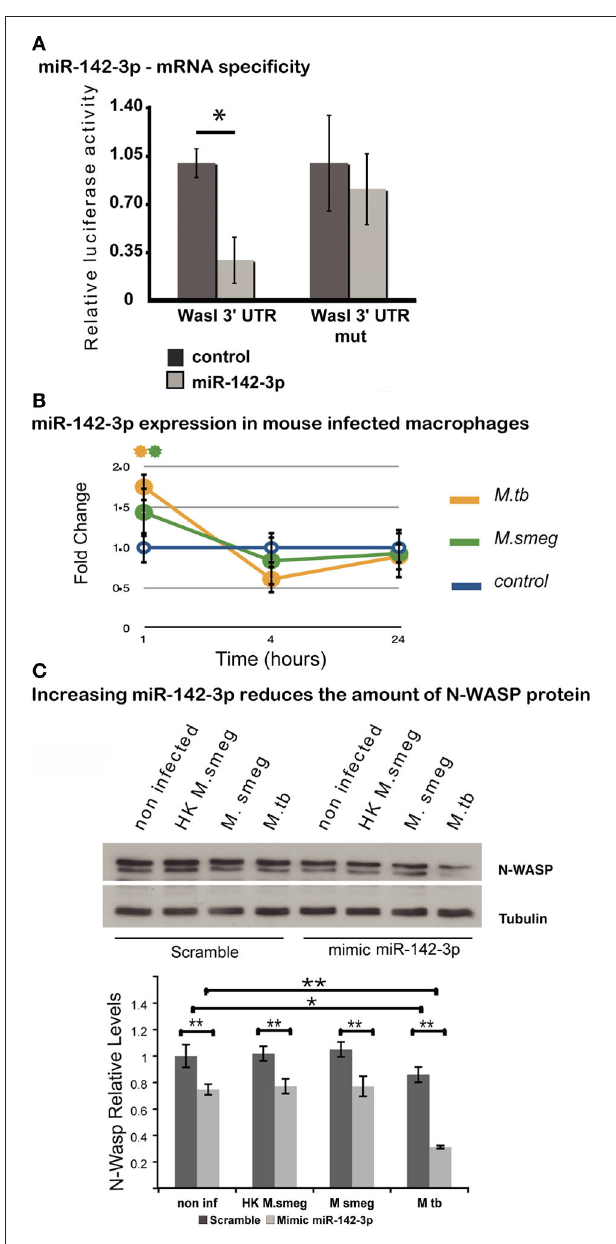
FIGURE 2 | N-Wasp is a target of miR-142-3p. (A) Luciferase assay showing the specific targeting of the 3 (cid:2) UTR of the mRNA of Wasl by the miR-142-3p. Data are represented as the mean fold change per sample ± SD ( ∗ P ≤ 0 . 01). (B) Relative expression of miR-142-3p in J774A.1 macrophages infected with M. smegmatis or M. tuberculosis (MOI 10), as measured by the EXIQON (DK) microRNA qPCR services. Data is represented as the mean fold change per sample ± SD at 1, 4, and 24h post-infection ( ∗ P ≤ 0.05 relative to control). (C) Relative protein levels by western blot in J774A.1 macrophages transfected with mimics of miR-142-3p or not, and that of internalized mycobacteria (MOI 10) after a 1-h challenge. N-Wasp levels are relative to that of α / β -Tubulin. A representative blot from three independent experiments is shown with the densitometry quantification: quantification of the relative levels of N-Wasp in infected macrophages, treated with either mimics of miR-142-3p or scramble ( ∗ P ≤ 0 . 01; ∗∗ P ≤ 0 .